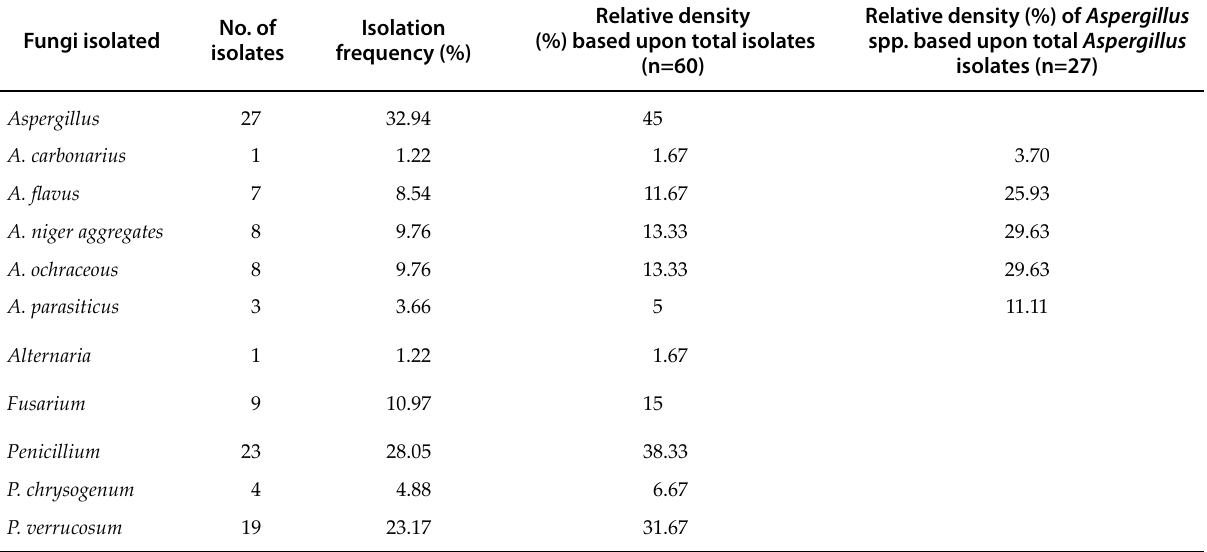
Table 1. Isolation frequency and relative density of different fungal genera and species isolated from maize samples (n=82). Fungi isolated